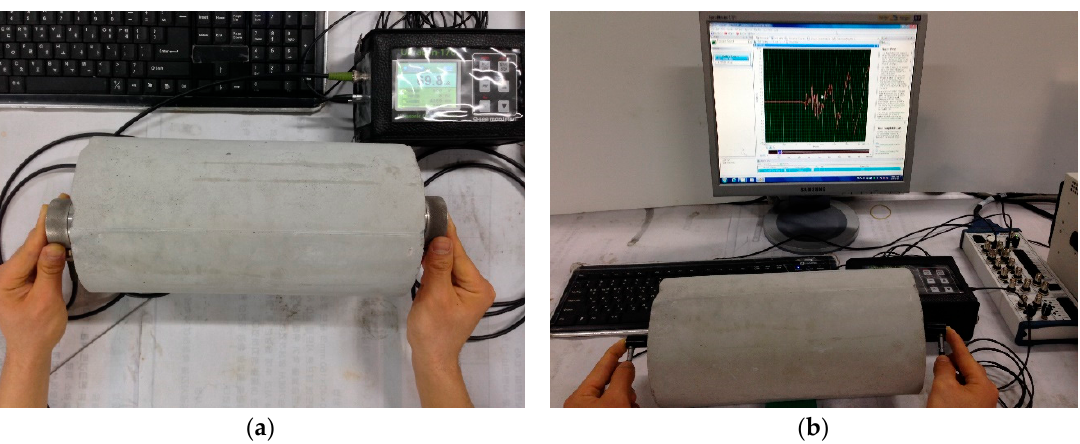
Figure 2. Methods for measuring ( a ) ultrasonic pulse velocity using a P-wave transducer (MK 954) and ( b ) ultrasonic shear-wave velocity using an S-wave transducer (ACS T1802).